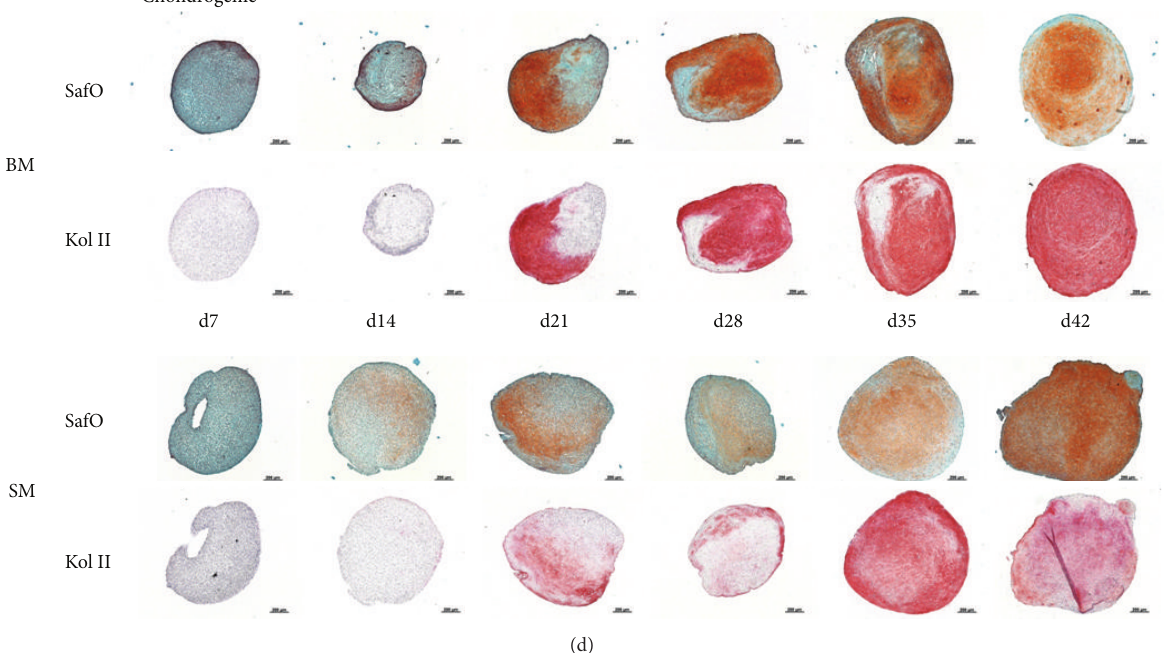
Figure 1: Mononuclear cell infiltration in the synovial membrane and MSC differentiation results. (a) The boxplot diagram displays the percentages of positive cells for the mononuclear cell fraction, CD14+ monocytes, CD16+CD56+ NK cells, CD4+ and CD8+ T-cells, and B-cells in the synovial membrane of 10 patients enclosed in the study. (b–d) Differentiation into the three lineages was successful in all MSCs ( 𝑛 = 5 patients per assay), while important donor-dependent variations were observed. (b) The figure shows representative results of adipogenic differentiation at d14 and d21 as defined by Oil Red O-stained lipid vacuoles. (c) Osteogenic differentiation was determined by calcium deposition through Alizarin Red staining (quantitative analysis of the reextracted dye is depicted in the diagram) and was enhanced in BM-MSCs compared to SM-MSCs. (d) Chondrogenic differentiation was assessed by Safranin O and Collagen II staining. ∗ refers to significant differences between the groups ( 𝑝 < 0.05